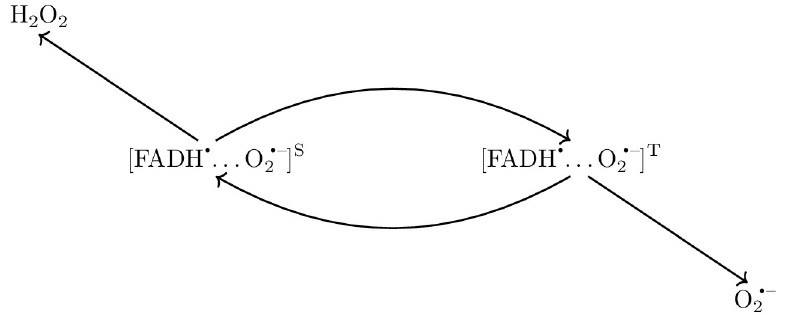
Fig 1. Schematic of radical pair mechanism for [FADH • ... O 2• − ] radical pair.